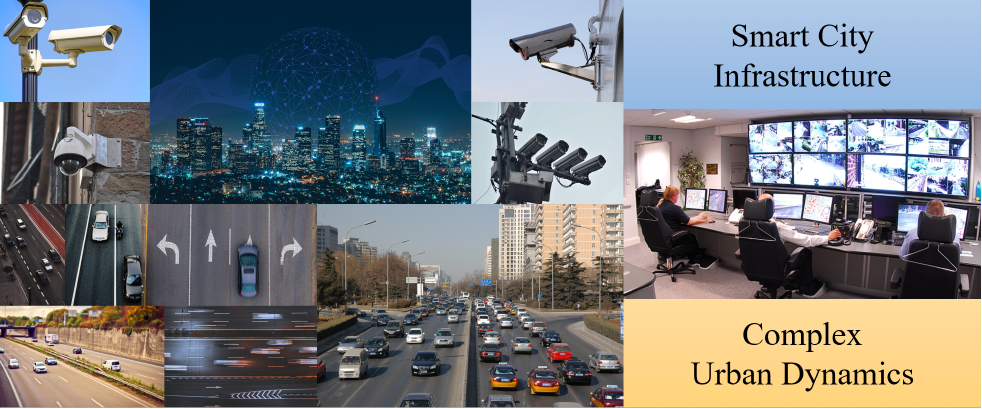
Figure 1. Pervasive visual sensors capture complex urban dynamics in smart